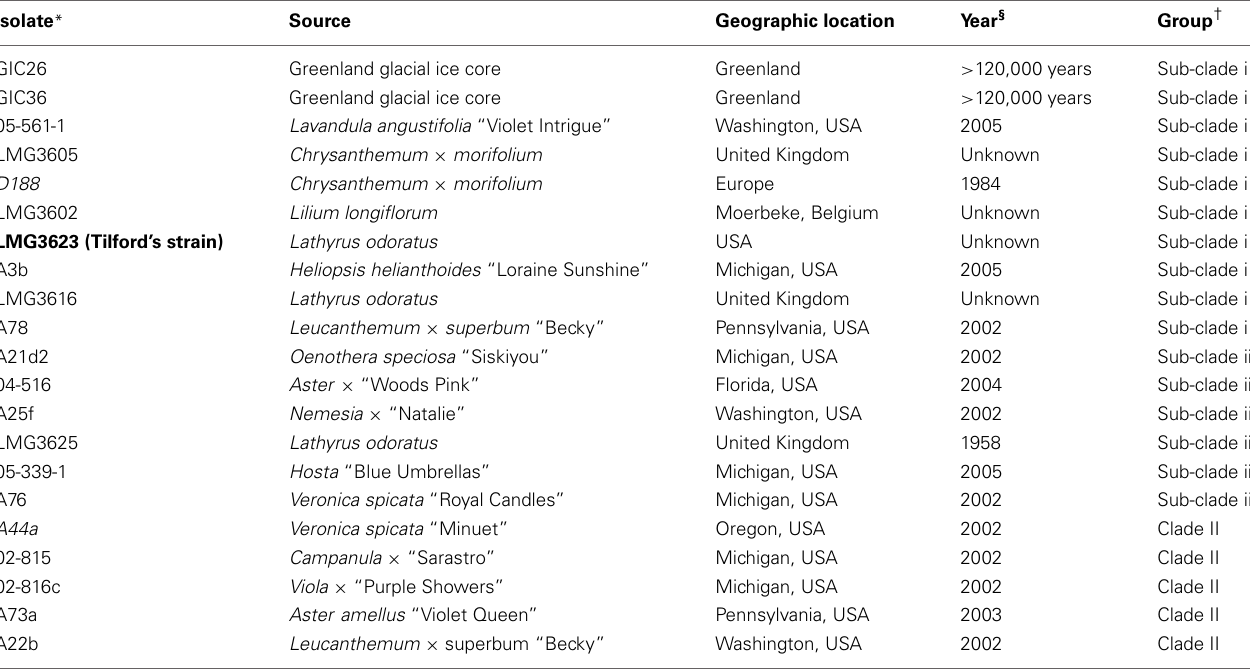
Table 1 | Isolates of Rhodococcus selected for whole genome